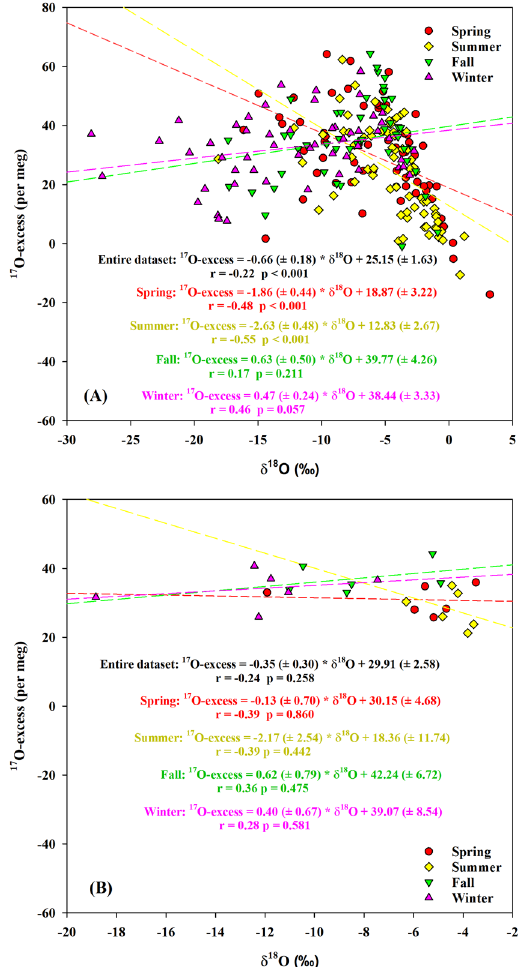
Figure 5. The relationships between 17 O-excess and δ 18 O based on daily ( A ) and monthly ( B ) precipitation within different seasons between June 2014 and May